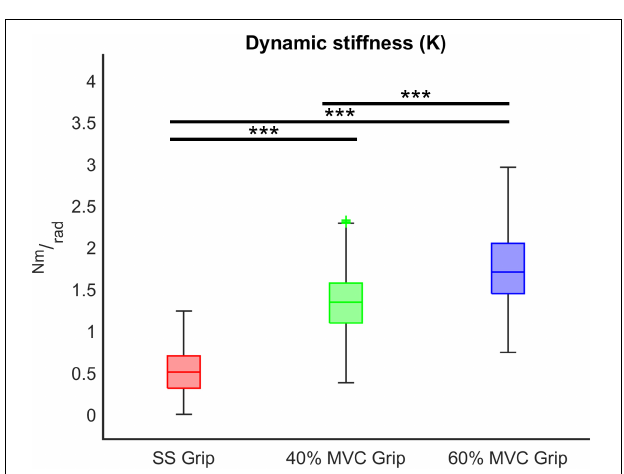
FIGURE 7 | K (Nm/rad) across different grip conditions (SS Grip, 40% and 60% of MVC Grip Force). These data belong to the RH group. ***, statistically significant, p <